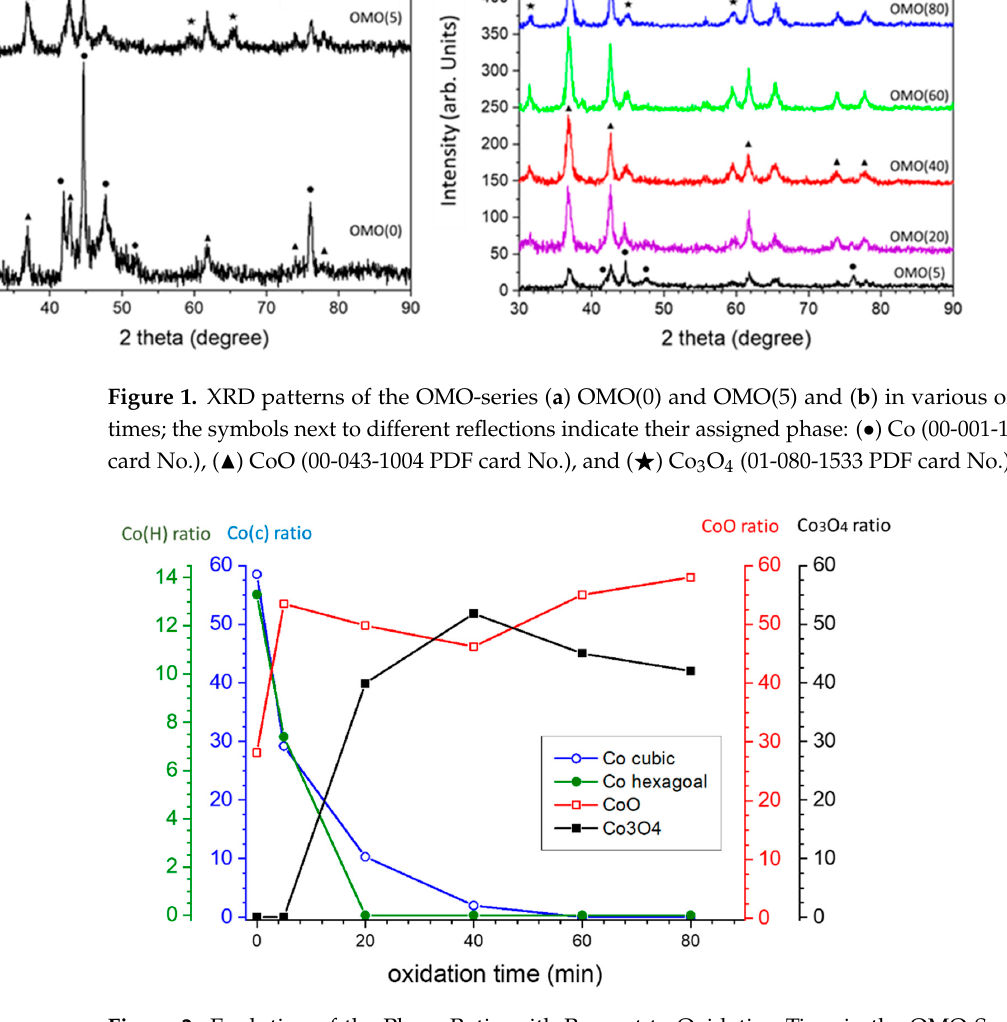
Figure 2. Evolution of the Phase Ratio with Respect to Oxidation Time in the OMO-Series. The connecting lines are to aid visual tracking of the phase variations. Table 1. Summary of compositional and structural parameters extracted from magnetometry and XRD for the OMO-series. σ denotes saturation magnetization.